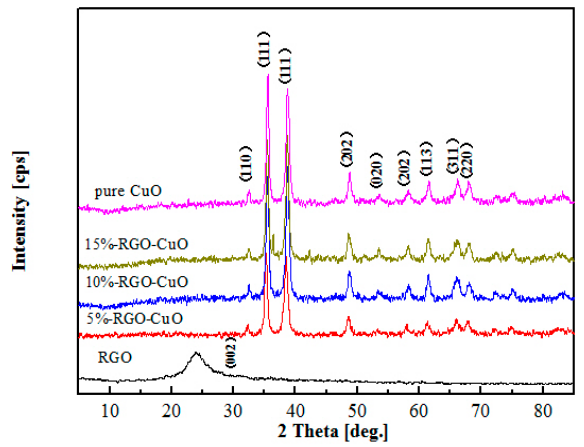
Figure 1. XRD patterns of the reduced graphene oxide (RGO), pure CuO, and RGO–CuO composites.